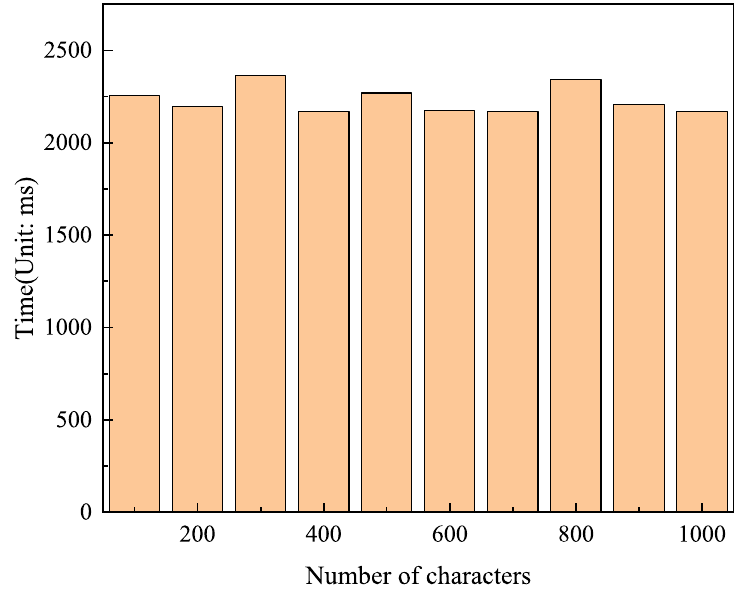
Figure 12. Generate block time with different character lengths.